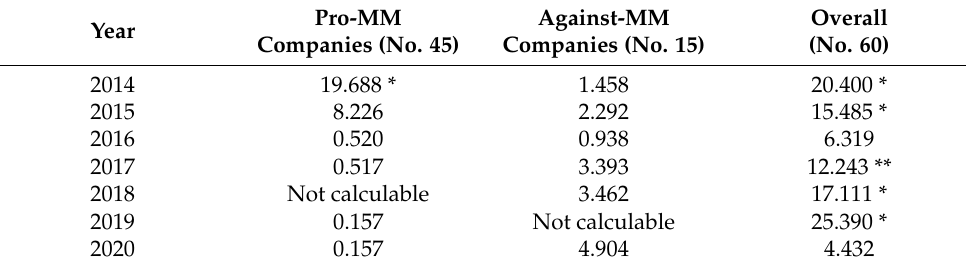
Table 8. Statistical association between yearly MM presentation and yearly GRI compliance: